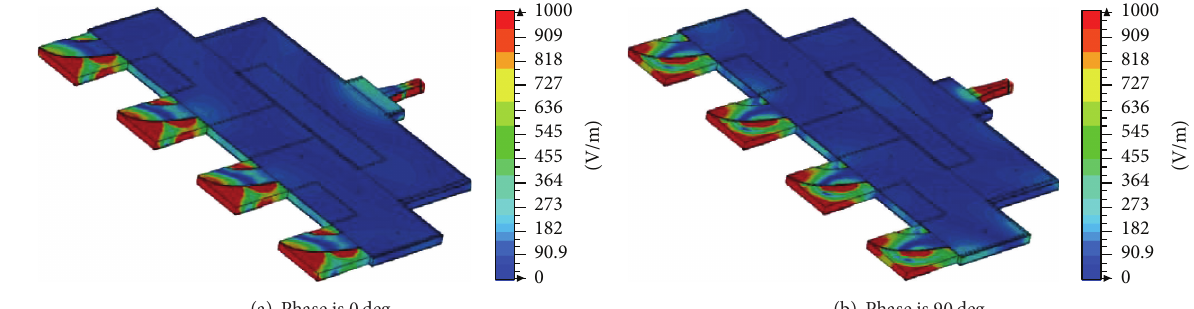
Figure 23: Electric field of the SIW Vivaldi antenna array.